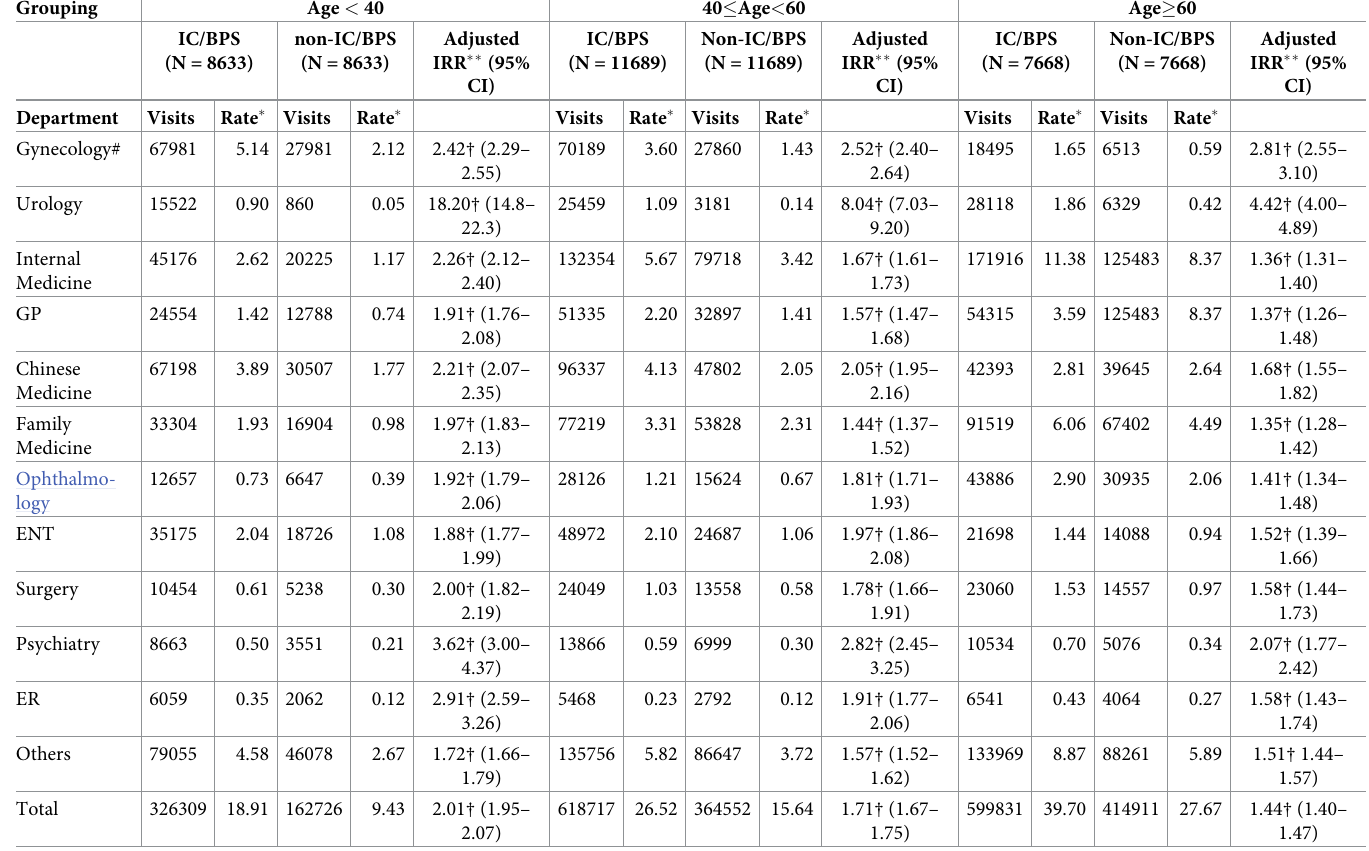
Table 3. Incidence rate ratio (IRR) of outpatient visits between IC/BPS and non-IC/BPS individuals categorized by 3 age groups.